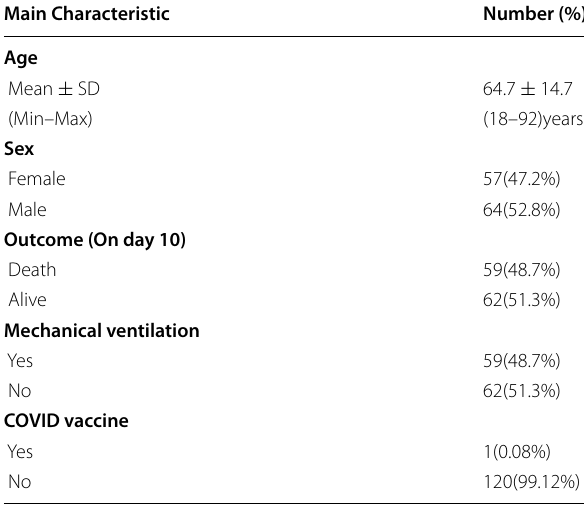
Table 1 Demographic data and main characteristics of the 121 participants involved in the